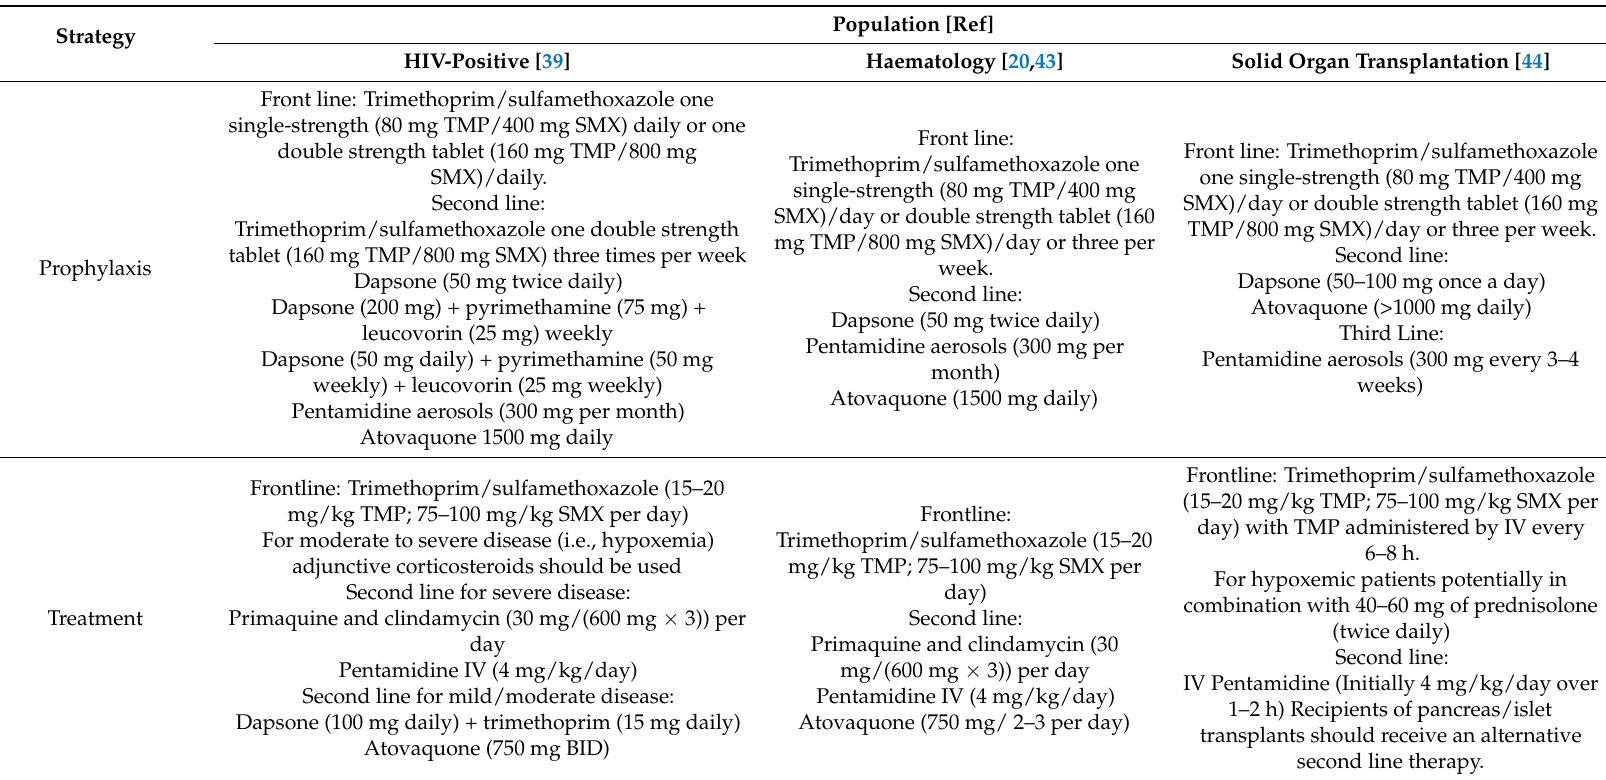
Table 4. Prophylactic and therapeutic options for the management of Pneumocystis pneumonia in HIV, haematology, and solid organ transplant